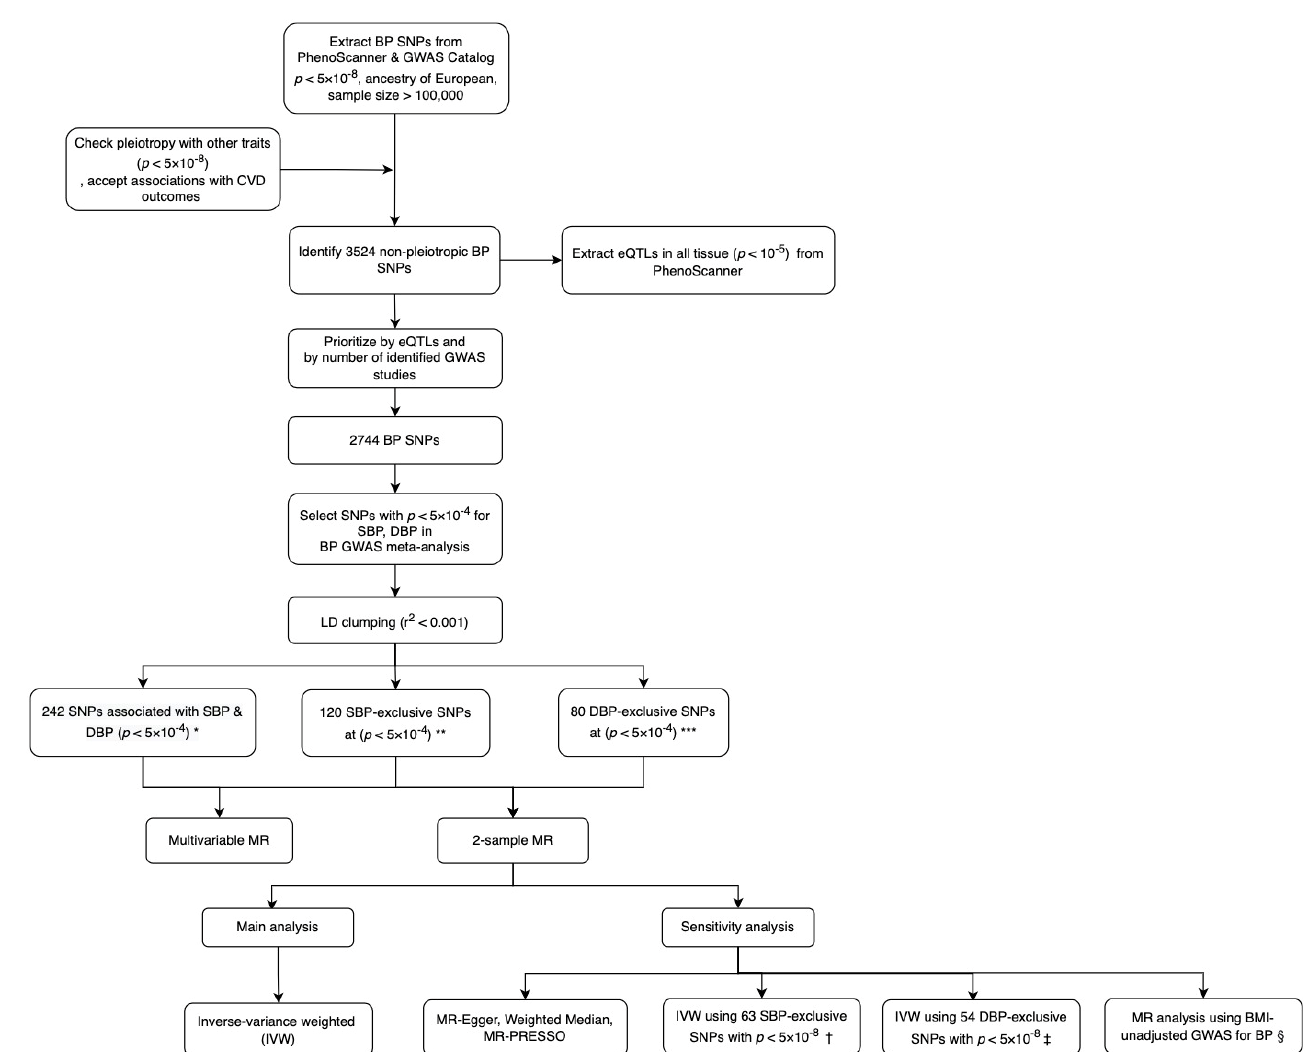
Figure 1. Flowchart illustrating the selection criteria for genetic instruments in this study. BP indicates blood pressure; SBP, systolic blood pressure; DBP, diastolic blood pressure; SNP, single nucleotide polymorphism; GWAS, Genome-wide association study; CVD, cardiovascular disease; eQTL, expression quantitative trait loci; LD, linkage disequilibrium; MR, Mendelian randomization; BMI, body mass index. * 242 SNPs associated with both SBP and DBP ( p < 5 × 10 − 4 ), identified in a BP GWAS meta-analysis study [17]. ** 120 SNPs associated with SBP but not associated with DBP ( p < 5 × 10 − 4 ). *** 80 SNPs associated with DBP but not associated with SBP ( p < 5 × 10 − 4 ). † 63 SNPs associated with SBP ( p < 5 × 10 − 8 ) but not associated with DBP ( p > 5 × 10 − 4 ). ‡ 54 SNPs associated with DBP ( p < 5 × 10 − 8 ) but not with SBP ( p > 5 × 10 − 4 ). § MR analysis unadjusted for body mass index, using summary statistics from UK BioBank